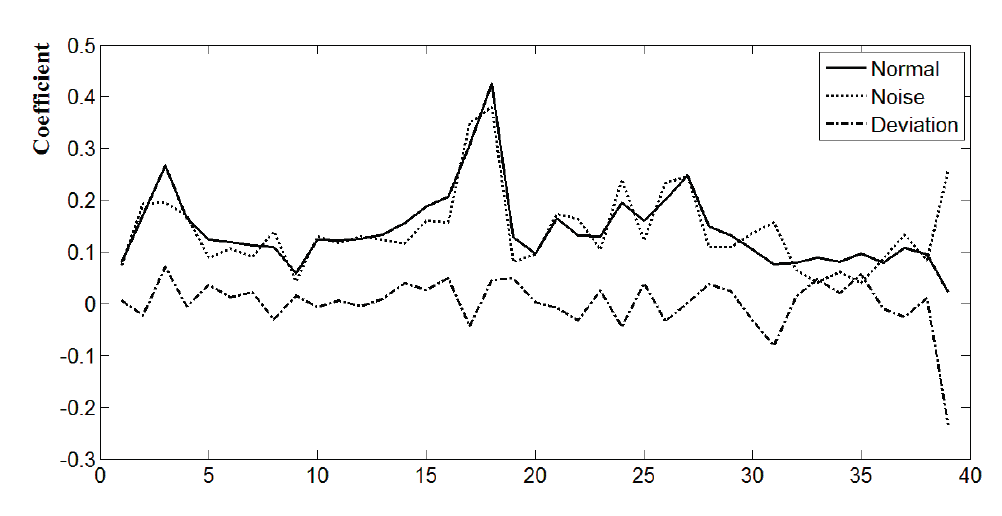
Figure 3. The noise influence in symmetrical short circuit